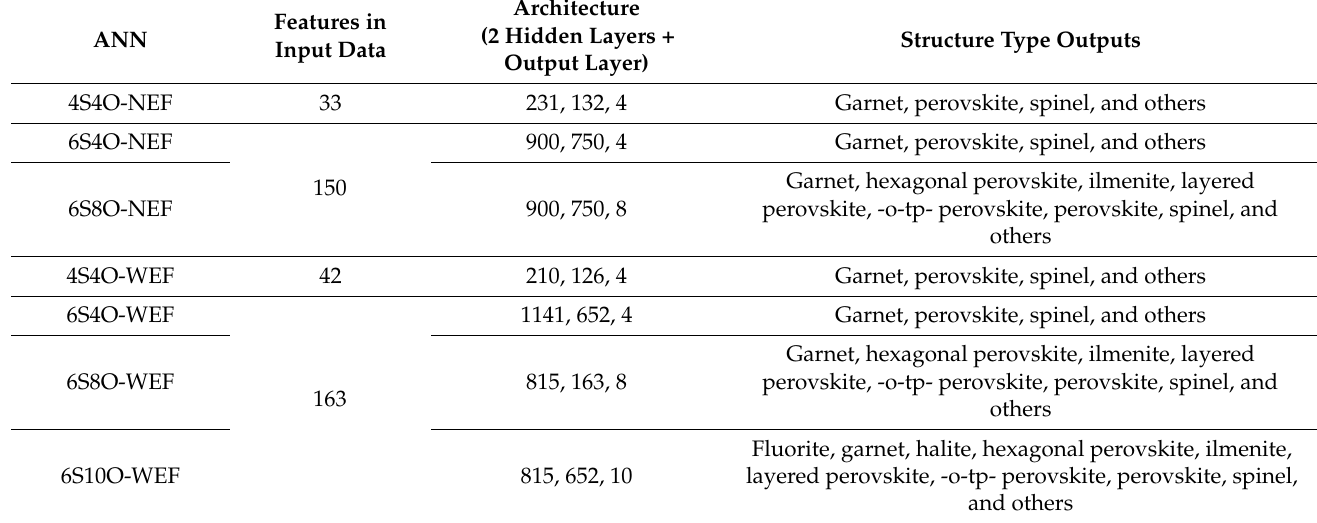
Table 1. Summary of the input data and the architectures of the developed ANNs. The first column enlists each of the ANNs. The second column refers to the dimension of the input vector of the ANNs, whereas the last column indicates the number of nodes in each